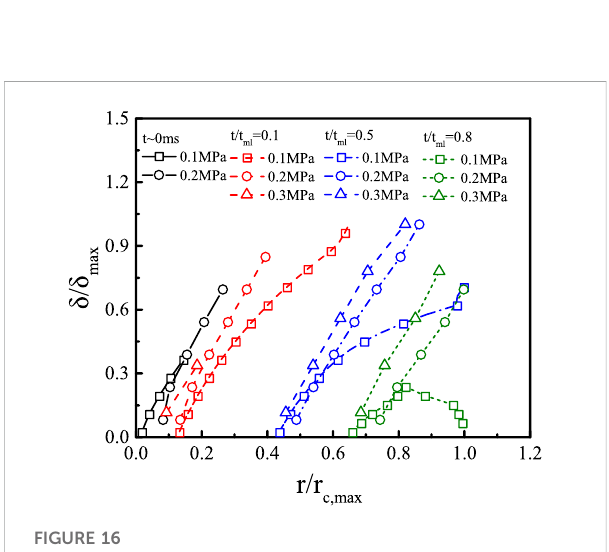
FIGURE 15 Comparison between the experimental data and the prediction with Eq. 6.